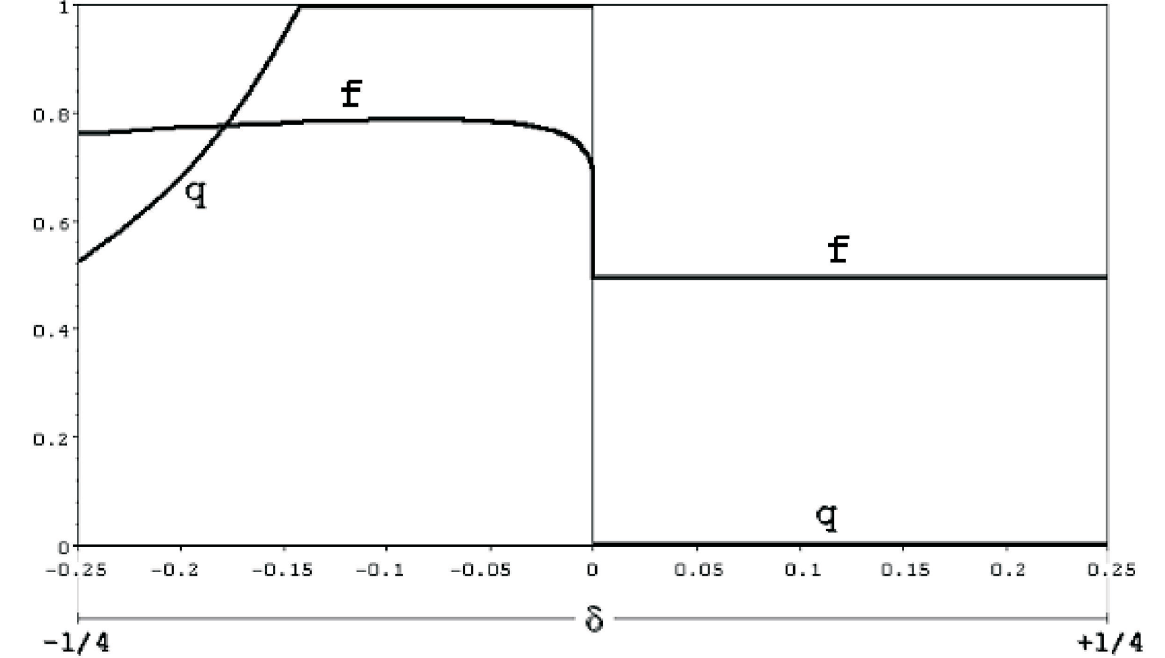
Figure 4 ‒ Population equilibrium frequencies of the mutant X-linked allele A (q) and of corresponding female frequencies (f), according to the value of the distortion factor δ (model